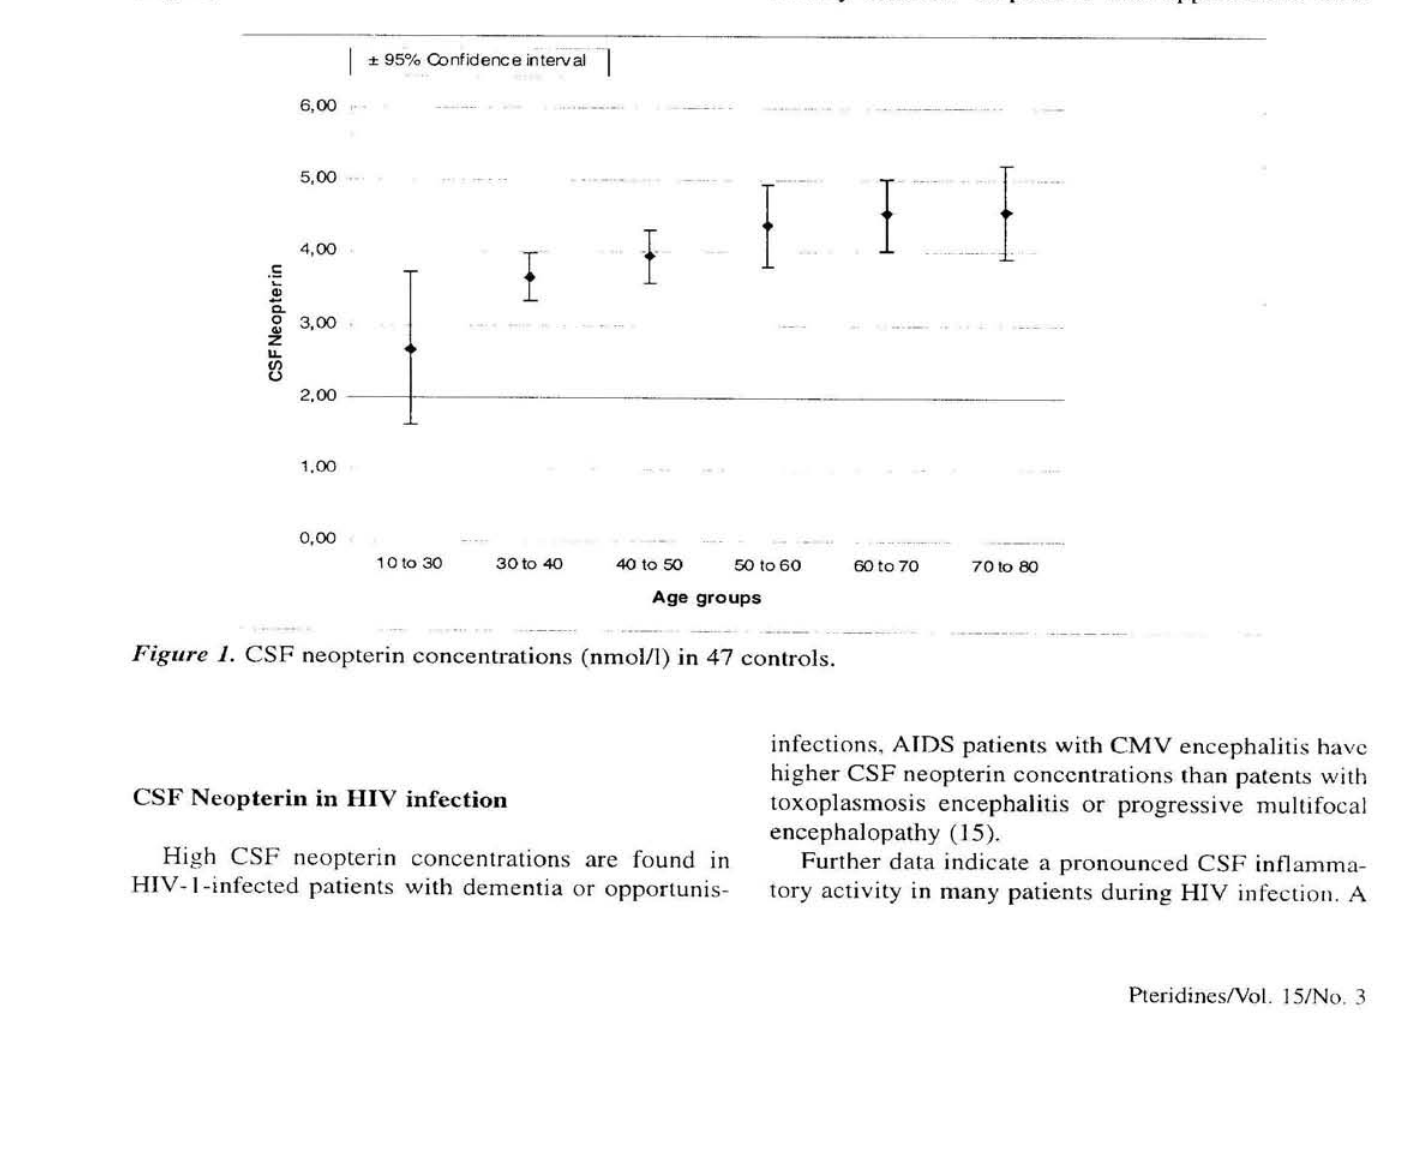
CSF Neopterin in HIV